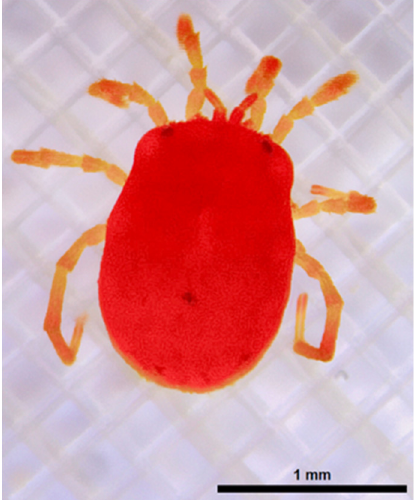
Figure 7. The invertebrate group of true freshwater mites (Acari and Hydrachnidia) is particularly relevant for spring monitoring due to their high share of specialized species exclusive to these habitats (crenobionts) and their dependence on continuous flow and stable conditions. The picture shows Partnunia steinmanni Walter: In a study on genetic exchange among populations of this species in National Parks of the Alps, Blattner et al. [61,62] showed that Alpine springs are relatively isolated habitats with island characteristics.